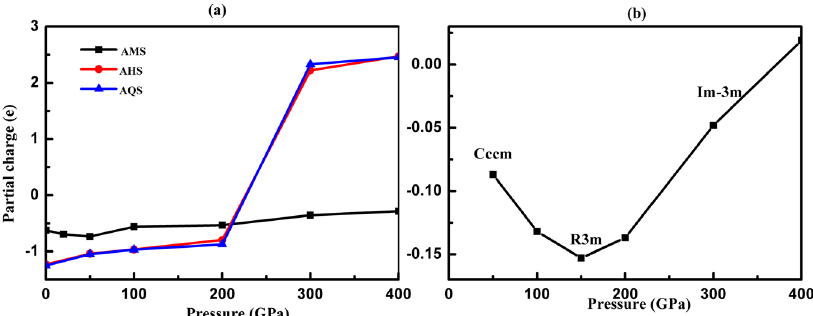
Fig. 4 Bader partial charge analyses. a Partial charges of sulfur atom s in different H 2 S-NH 3 mixtures. b Partial charges of sulfur atoms in H 3 S, for different solid phases